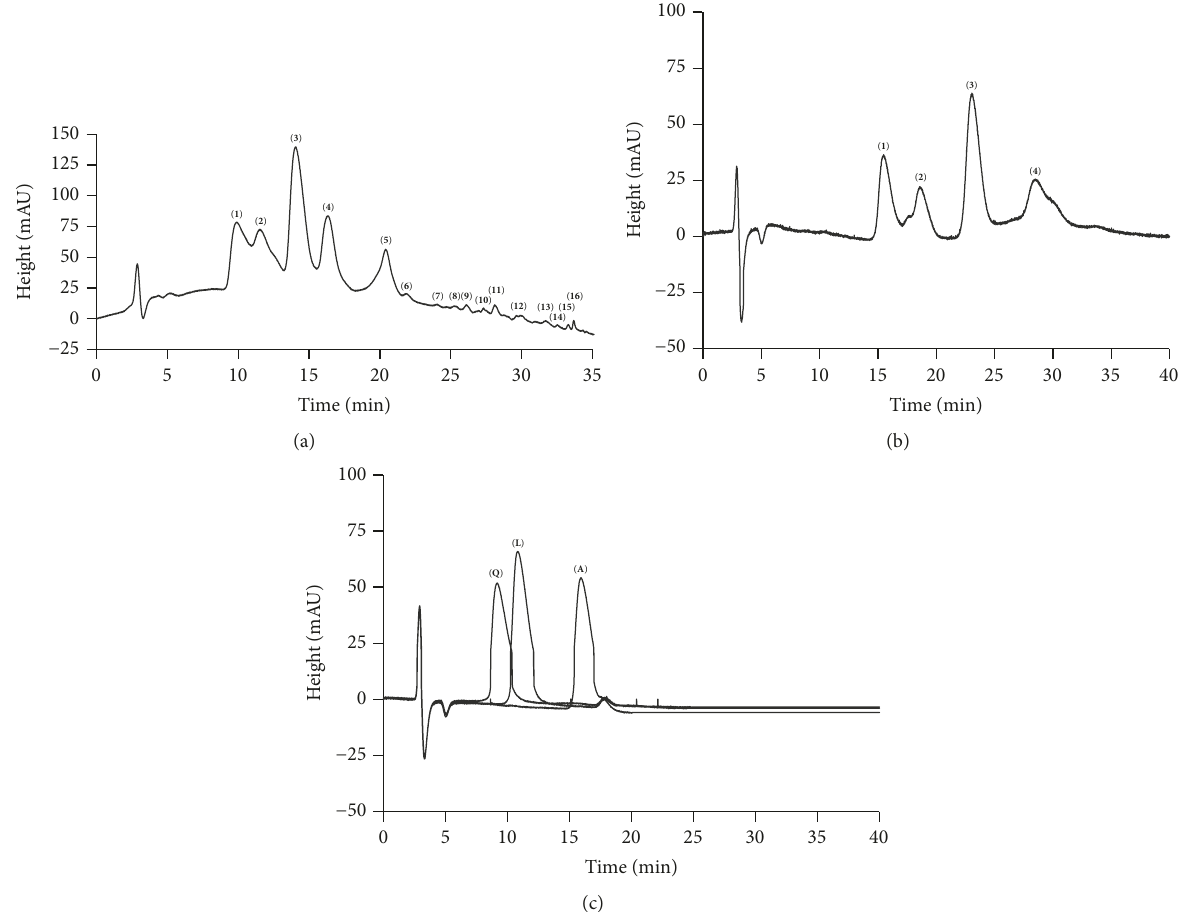
Figure 1: Chromatographic profile of hexane fraction from L. frutescens leaves (400 𝜇 g/mL) by HPLC (a) method 1: chromatogram shows 16 peaks-components with a retention time of 9.88, 11.50, 14.04, 16.34, 20.40, 21.88, 24.04, 25.30, 26.11, 27.32, 28.11, 29.94, 31.62, 32.52, 33.27, and 33.66 min. (b) Method 2: chromatogram shows 4 peaks-components with a retention time of 15.48, 18.61, 23.05, and 28.49 min. (c) Quercetin (Q), luteolin (L), and apigenin (A) with retention time of 9.31, 10.97, and 16.07 min, respectively, analyzed by method 2.